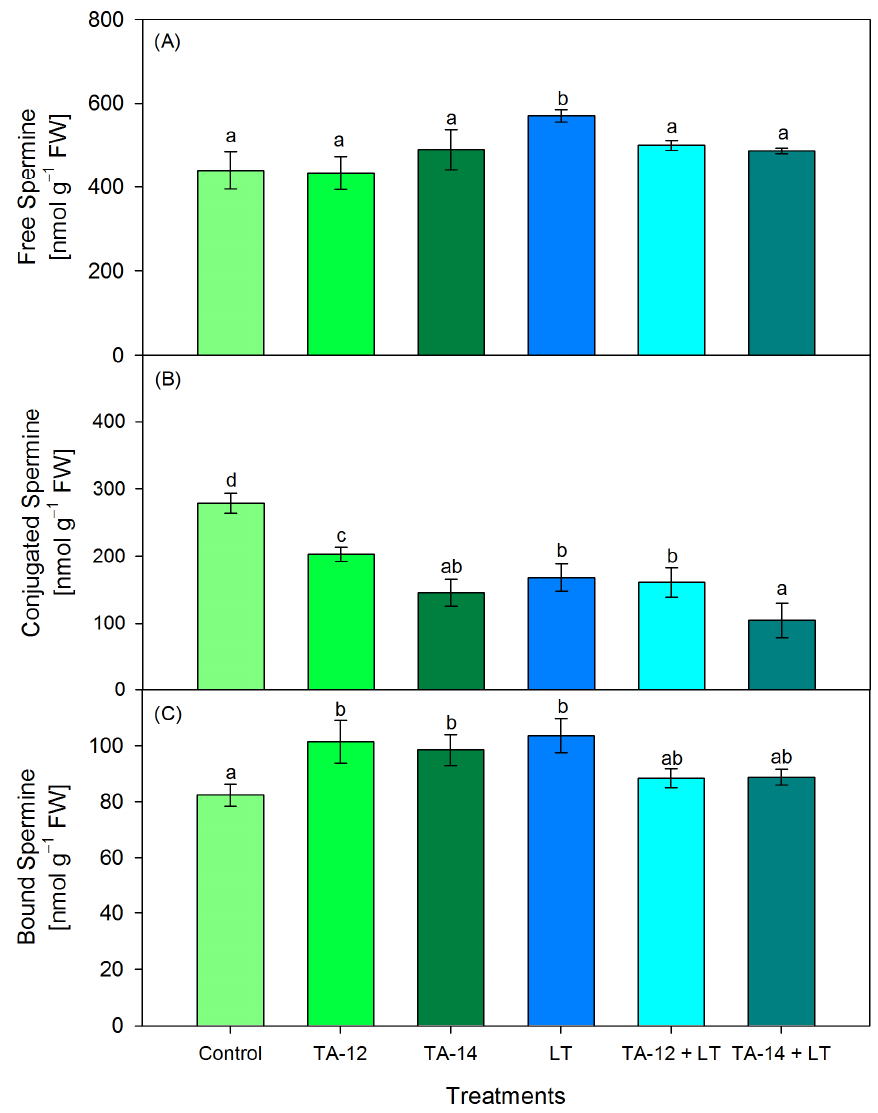
Figure 5. Content of free ( A ), conjugated ( B ) and bound ( C ) spermine (Spm) in pea sprayed with TA-12 or TA-14 and subjected to low temperature (−1 °C, LT) for 24 h. Data are mean values ± SE. Different letters designate statistically significant difference at p <